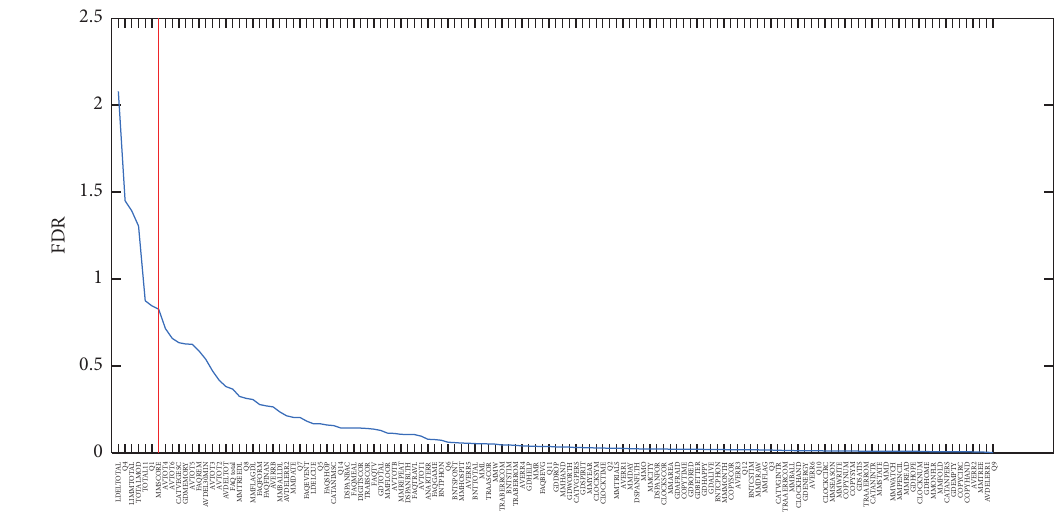
Figure 1: Representative example for one round and one iteration (CDR = 1 versus CDR = 0, round #1, iteration #1) of features ordered according to their FDR. Table 3: Performance of ML (accuracy, sensitivity, specificity, GM, and Dominance) in the classification of CDR = 1 versus CDR = 0 using linear, quadratic, Gaussian RBF, and Multilayer Perceptron kernels. Results were obtained using the computation-based feature reduction.